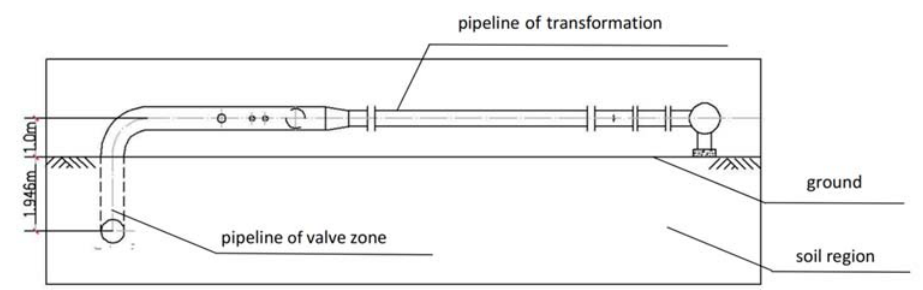
Figure 1. Diagram of the main pipeline in the valve zone.